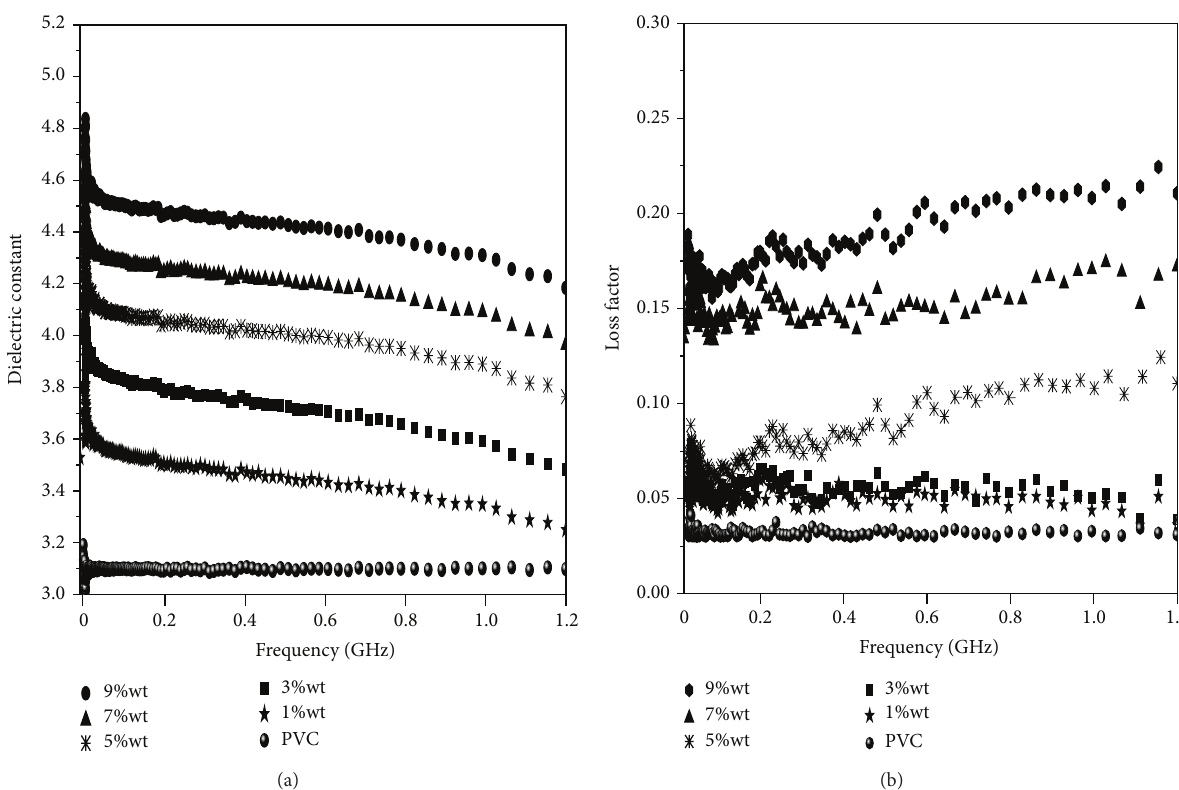
Figure 6: Dielectric properties of polyvinyl chloride-Zn/Al-NO 3 composites; (a) dielectric constant, (b) dielectric loss factor.